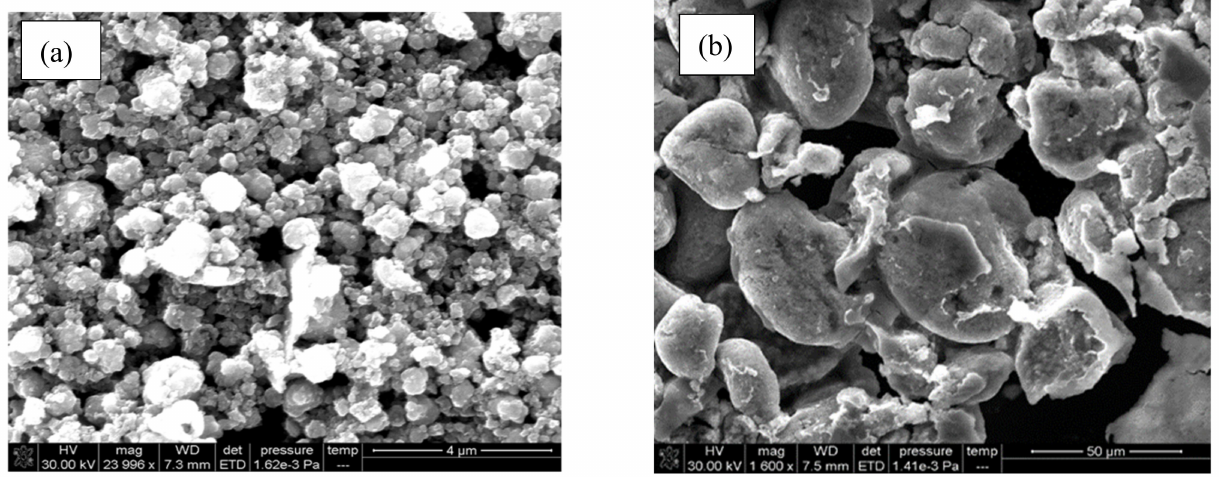
Figure 6. SEM micrograph of ( a ) Co 3 O 4 nanoparticles and ( b ) PANI/Co 3 O 4 nanoparticles.